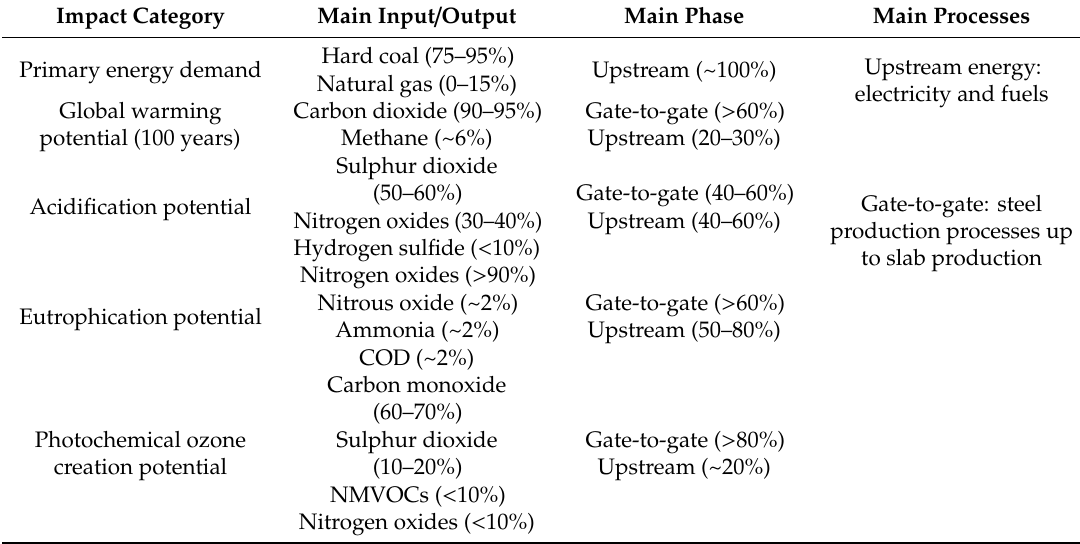
Table 3. Lifecycle significant flows, phases and processes in the worldsteel steel Life Cycle Inventory (excluding the end-of-life